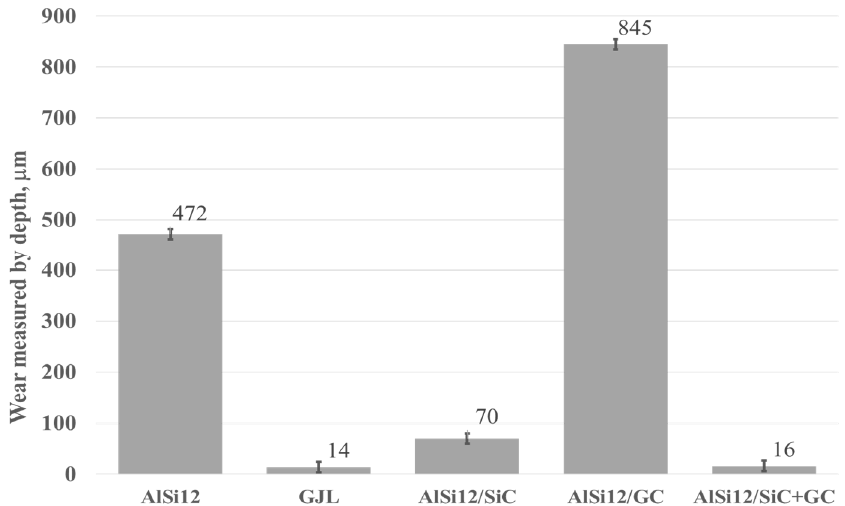
Figure 14. Depth of the wear track calculated based on 100 profiles.